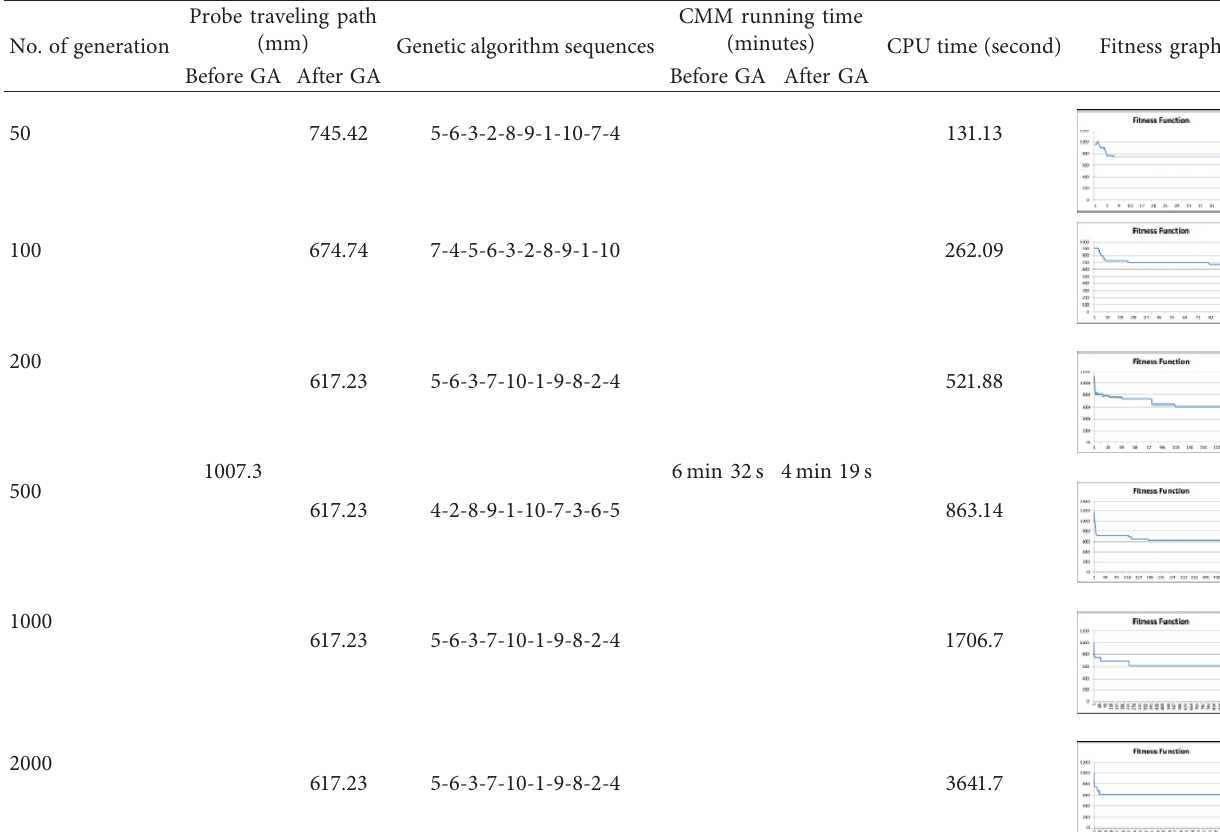
Figure 15: (a) Stress distribution; (b) resultant total deformation. Table 12: Application of the GA to determine the inspection path for a